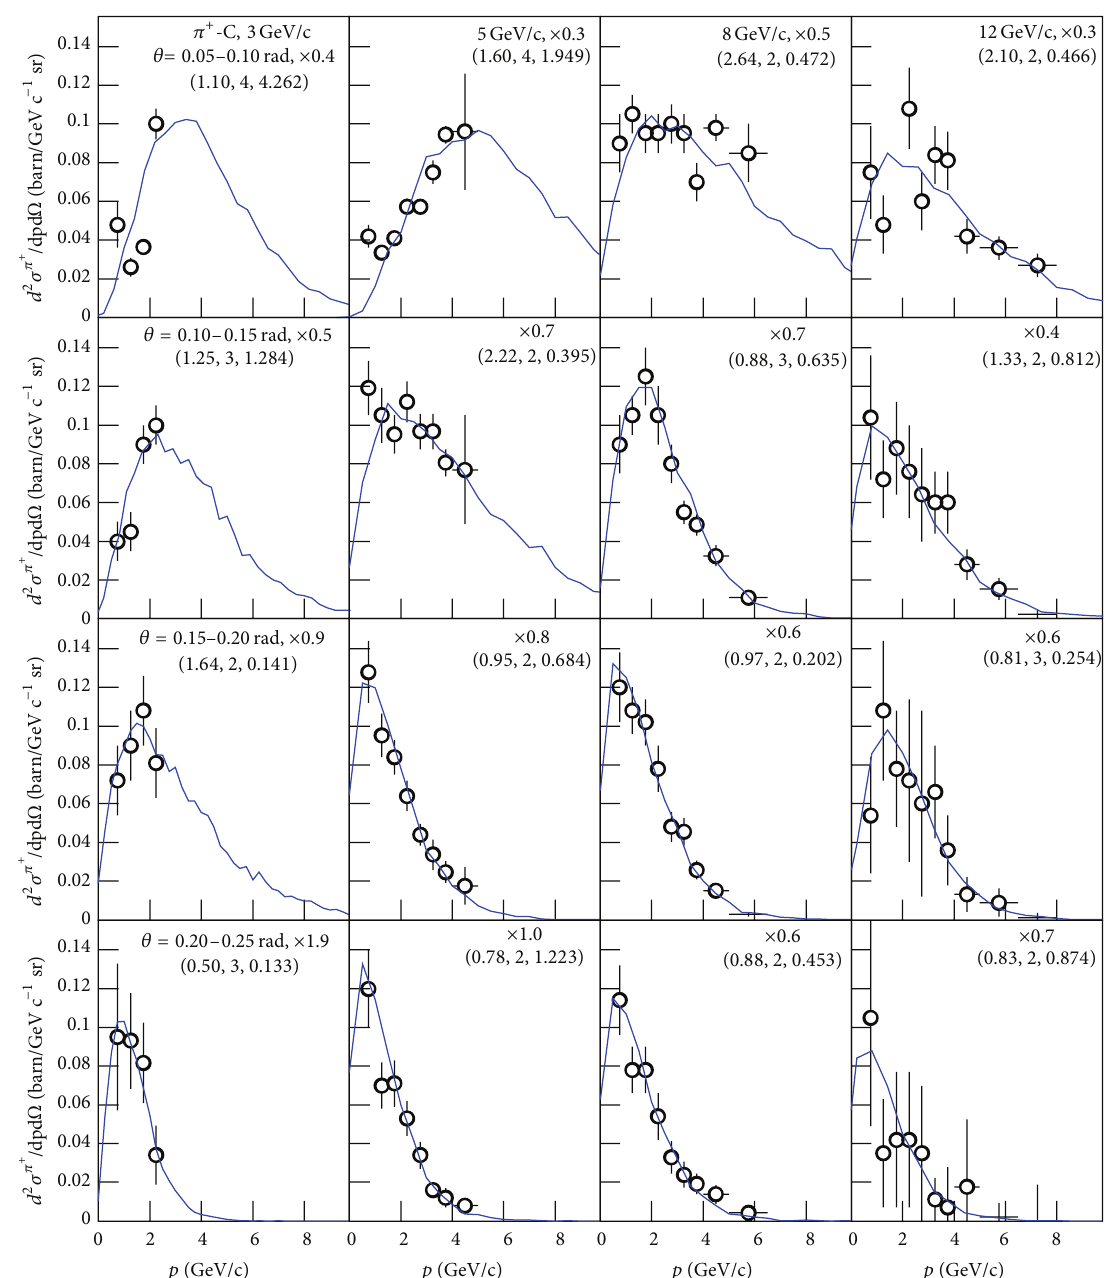
Figure 7: The same as Figure 1, but showing the results for 𝜋 + production cross sections in 𝜋 + -C interactions.